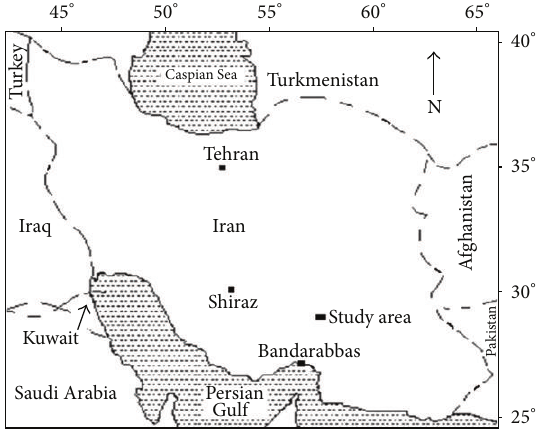
Figure 1: Location of the study